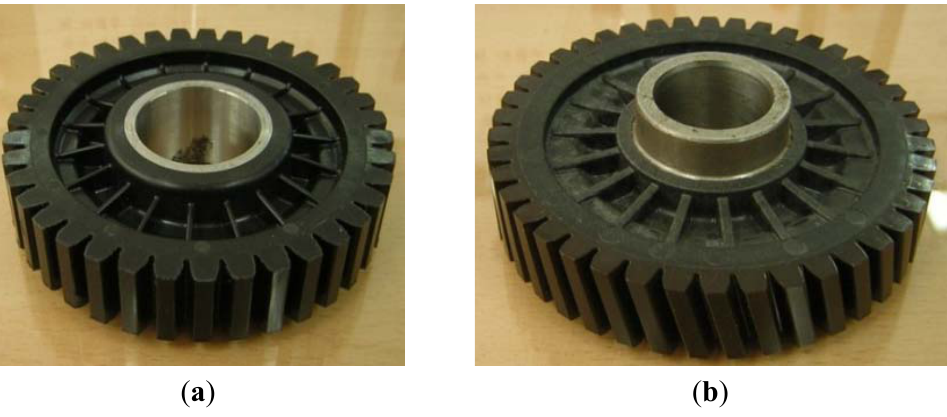
Figure 9. Plastic worm wheels manufactured by injection molding. ( a ) Plastic worm wheel with spur tooth form; ( b ) Plastic worm wheels manufactured by injection molding.